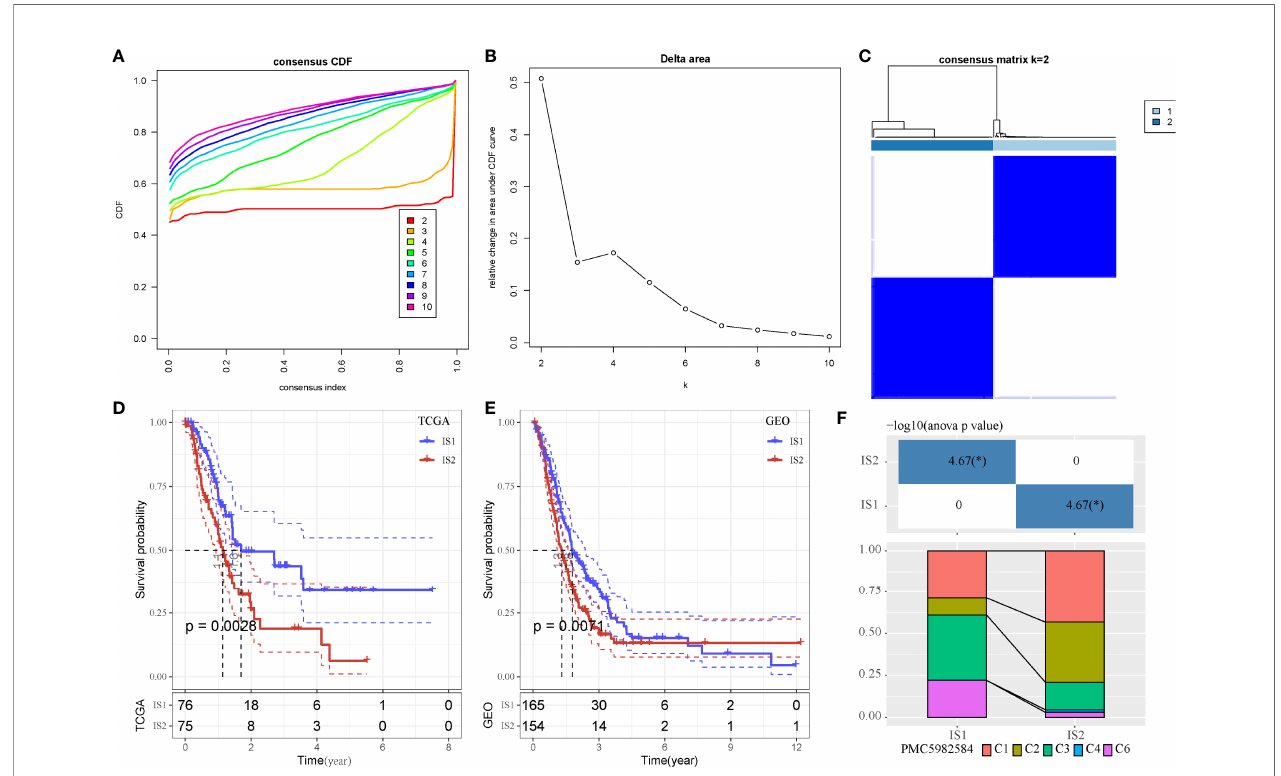
FIGURE 3 | Unsupervised consensus clustering of PAAD samples based on markers of MBCs in TCGA-PAAD cohort. (A, B) Consensus CDF curve and area under CDF curve when k = 2 – 10. (C) Consensus matrix when k = 2. (D, E) Kaplan – Meier survival plot of IS1 and IS2 groups in TCGA-PAAD and GEO cohorts. Log-rank test was conducted. CDF, cumulative distribution function. (F) Intersection between two molecular subtypes and the previous six immune subtypes.* P <